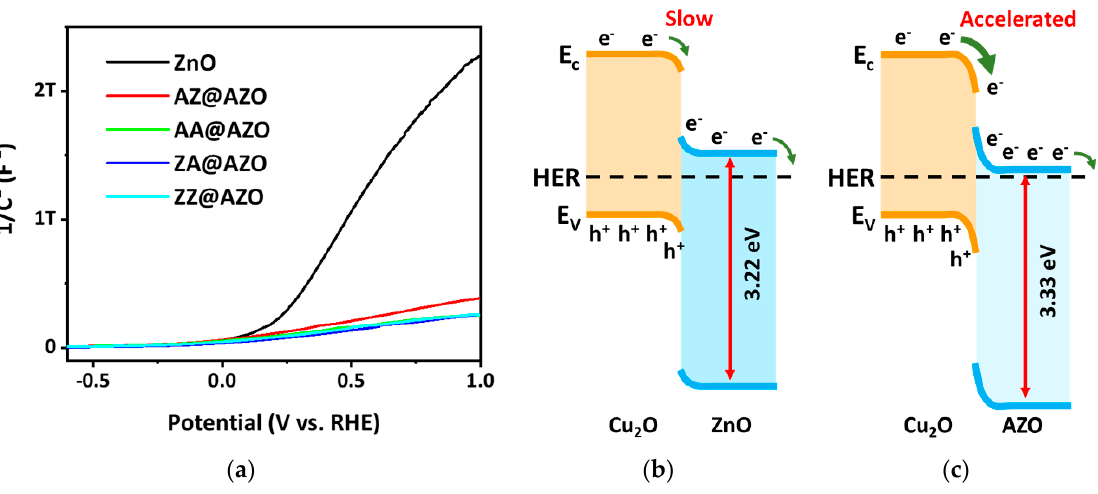
Figure 5 . ( a ) Mott–Schottky plots of ZnO and AZO overlayers. Schematic band diagrams of the ( b ) Cu 2 O/ZnO and ( c ) Cu 2 O/AA@AZO junctions estimated from the Mott-Schottky plots.